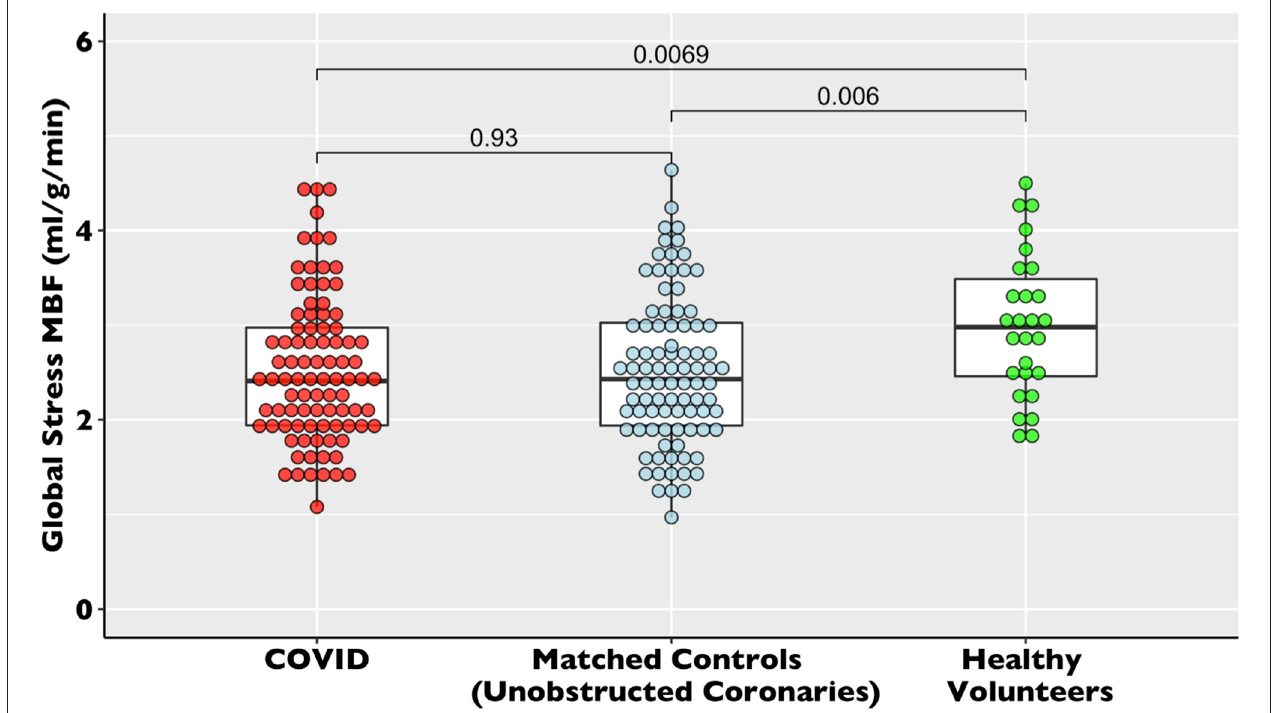
FIGURE 3 | Global stress myocardial blood flow (MBF) in recovered post-COVID19 patients vs. propensity-matched controls and healthy volunteers. The dot plot of global stress myocardial blood flow for the COVID-19, control, and healthy volunteer cohorts. The data are presented with accompanying box